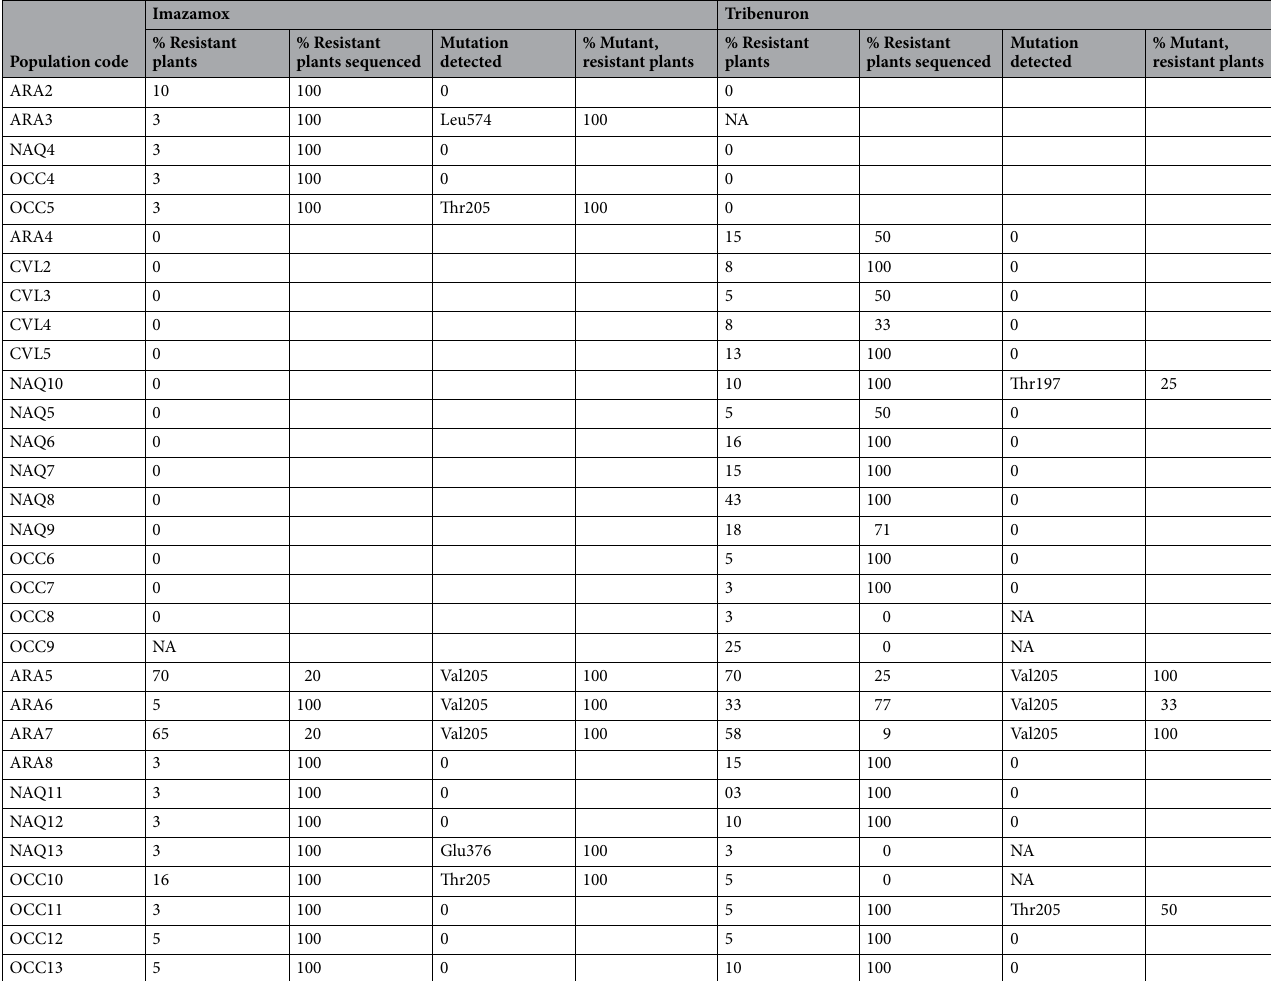
Table 2. Occurrence and frequencies of imazamox-resistant plants and of tribenuron-resistant plants in the 31 populations from the targeted sampling (43 populations in total) where at least one resistant plant was detected by herbicide sensitivity bioassays. Mutant ALS alleles were sought in resistant plants by Sanger sequencing. Populations are grouped according to the presence of resistance to imazamox only, to tribenuron only, or to both herbicides. NA not